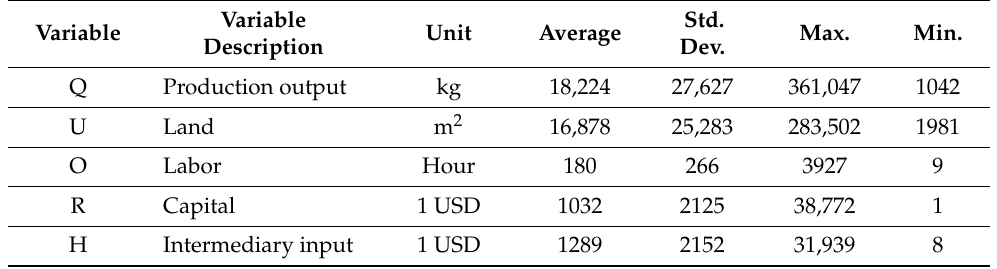
Table 4. Summary statistics of productivity estimation variables.